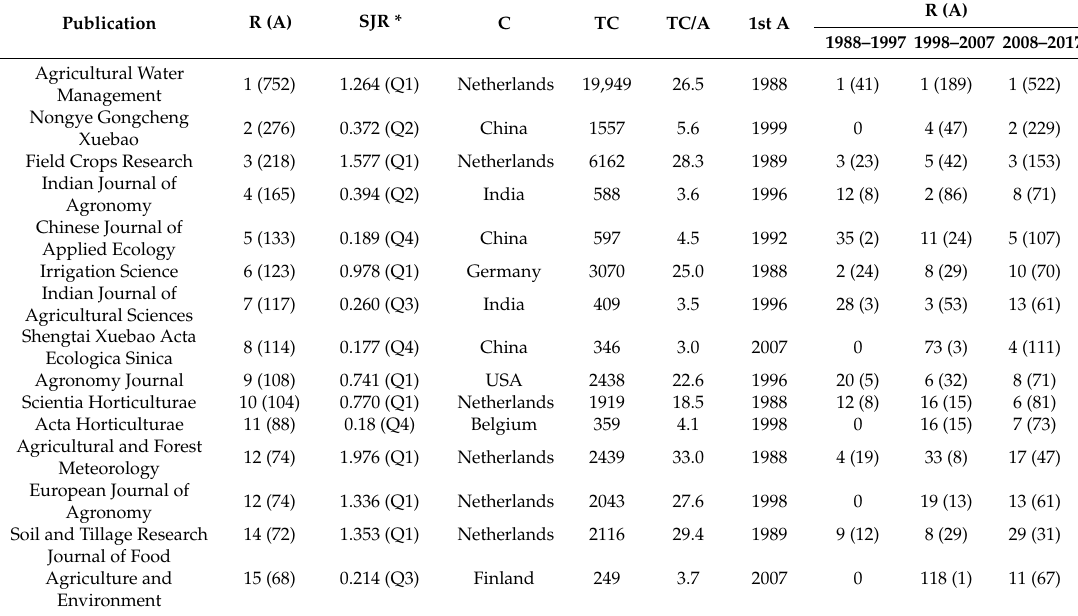
Table 2. Most productive journals for WUEA research from 1988 to 2017.